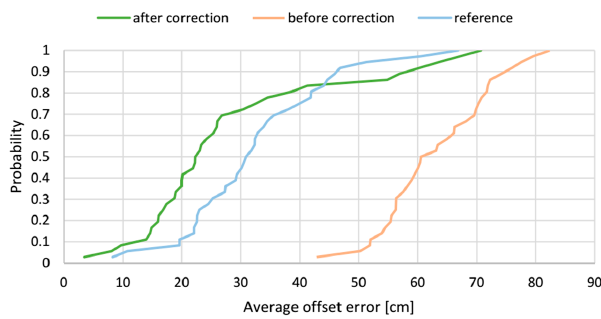
Figure 24. Experimental cumulative distribution functions of the average resultant offset error for LSs AD pair.